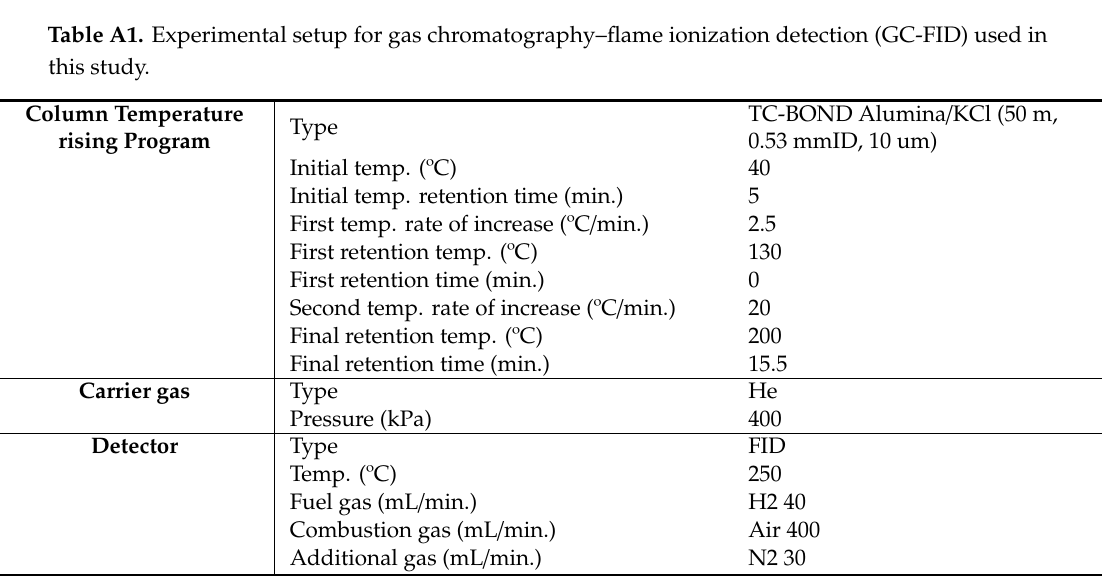
Table A2. Experimental setup of gas chromatography–mass spectrometry (GC-MS). Column